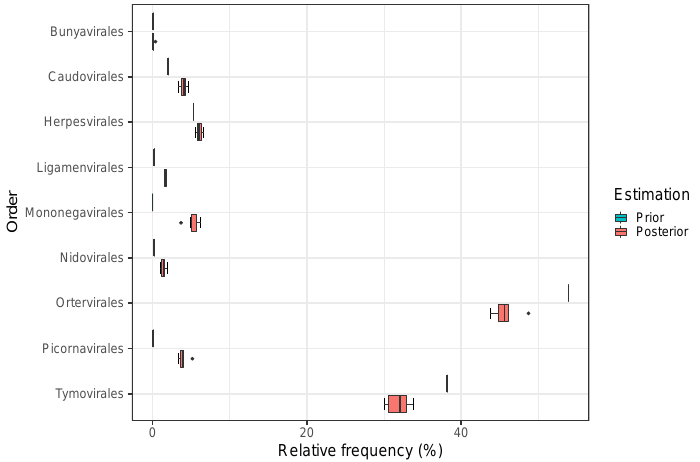
Figure 7. Taxa abundances of a harbour seal. While prior estimations of Bunyavirales , Ligamenvirales , Mononegavirales , Nidovirales and Picornavirales were very low, posterior estimations scaled up these taxa abundances. For Mononegavirales and Picornavirales this correction gap is large, whereas for Bunyavirales , Ligamenvirales and Nidovirales it is only small. In contrast, the frequency estimations of Ortervirales and Tymovirales , which were classified numerously by the ANN, were scaled